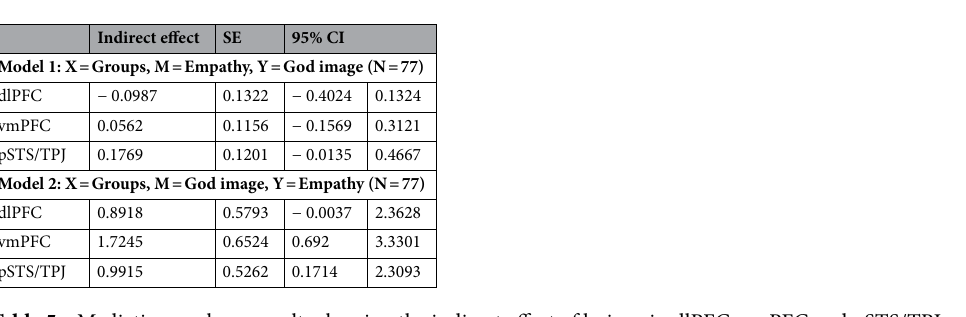
Table 5. Mediation analyses results showing the indirect effect of lesions in dlPFC, vmPFC and pSTS/TPJ relative to the HCs.